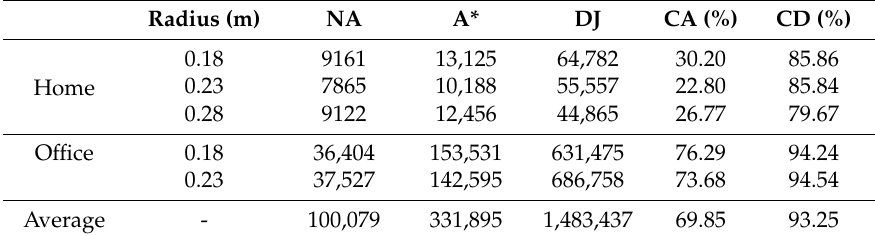
Table 6. Results of traversed cells numbers.